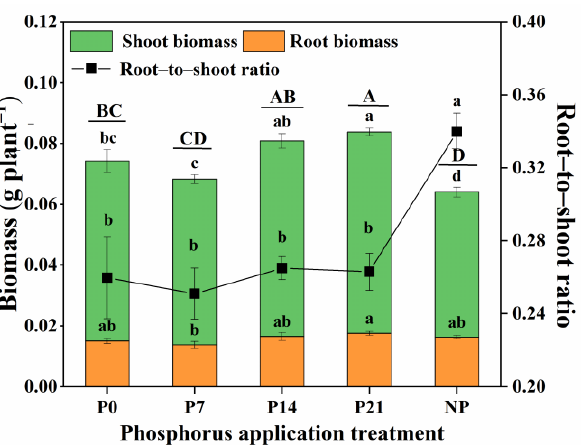
Figure 1. Shoot and root biomass and root−to−shoot ratio as a function of P application time. P0 means P application at planting; P7 means P application at 7 d after planting; P14 means P application at 14 d after planting; P21 means P application at 21 d after planting; and NP means no P application. Different capital letters mean significant differences in total biomass between treatments at p < 0.05, n = 4; different lowercase letters mean significant differences in either shoot biomass or root biomass among different treatments at p < 0.05, n = 4.